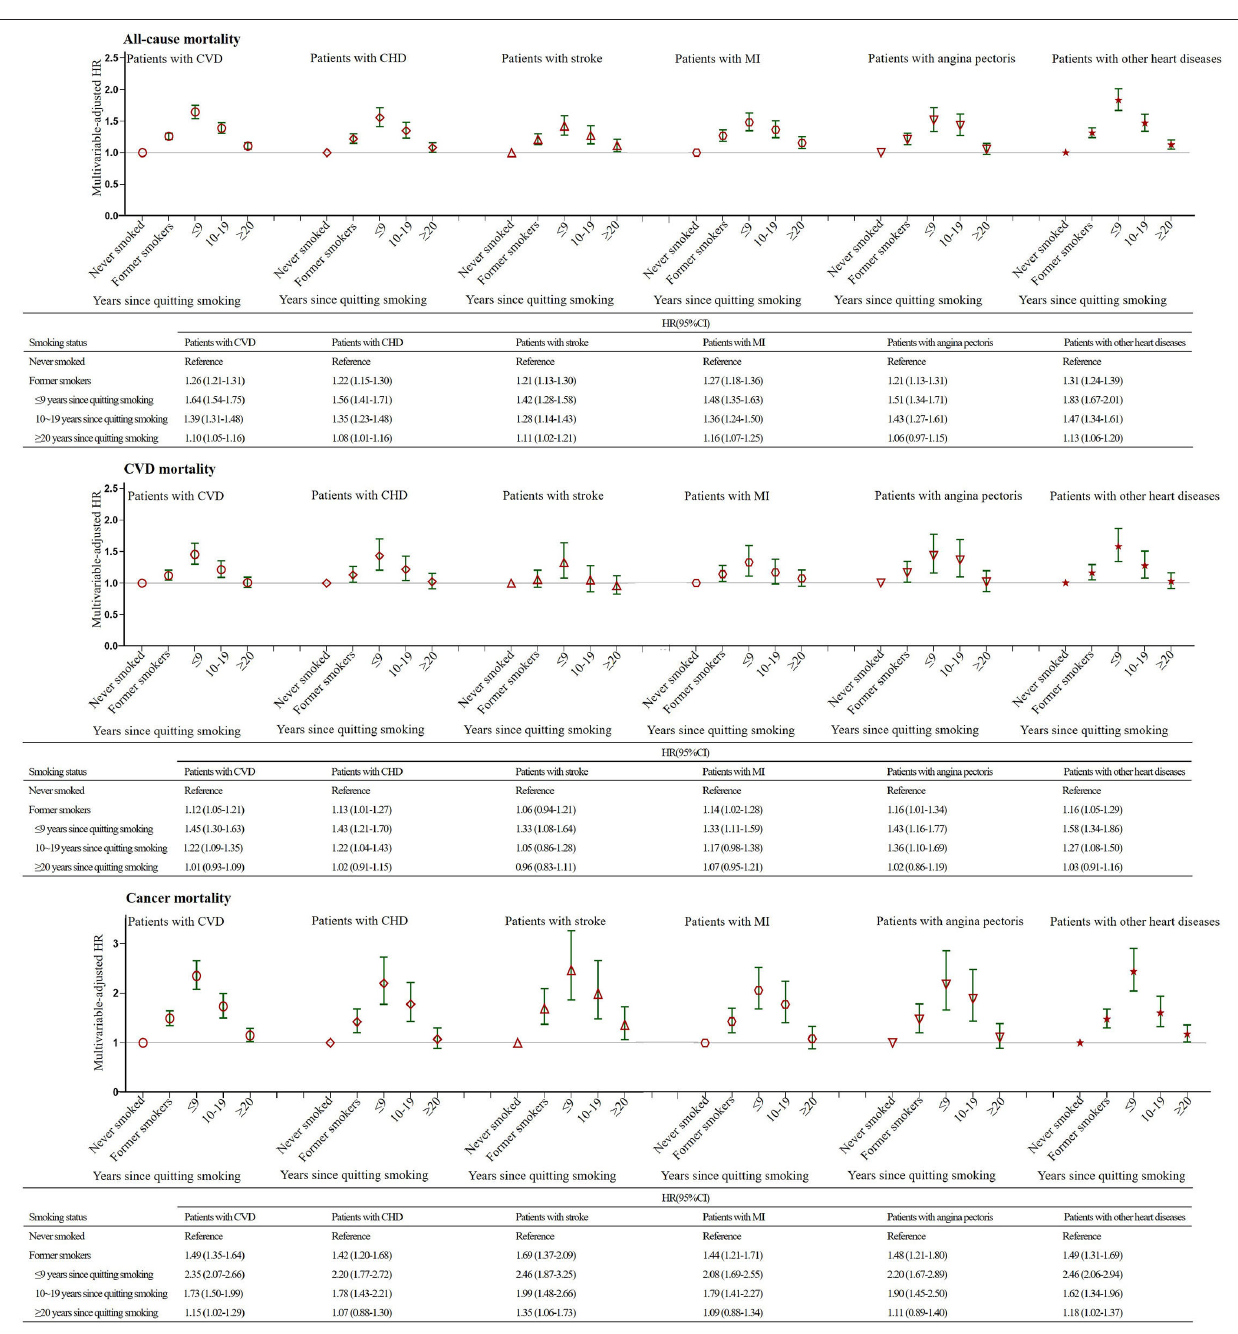
and cancer mortality, but the association for all-cause mortality was presented in a non-dose-response manner. Moreover, we observed that the risk of all-cause, CVD and cancer mortality declined as the number of years since quitting increased